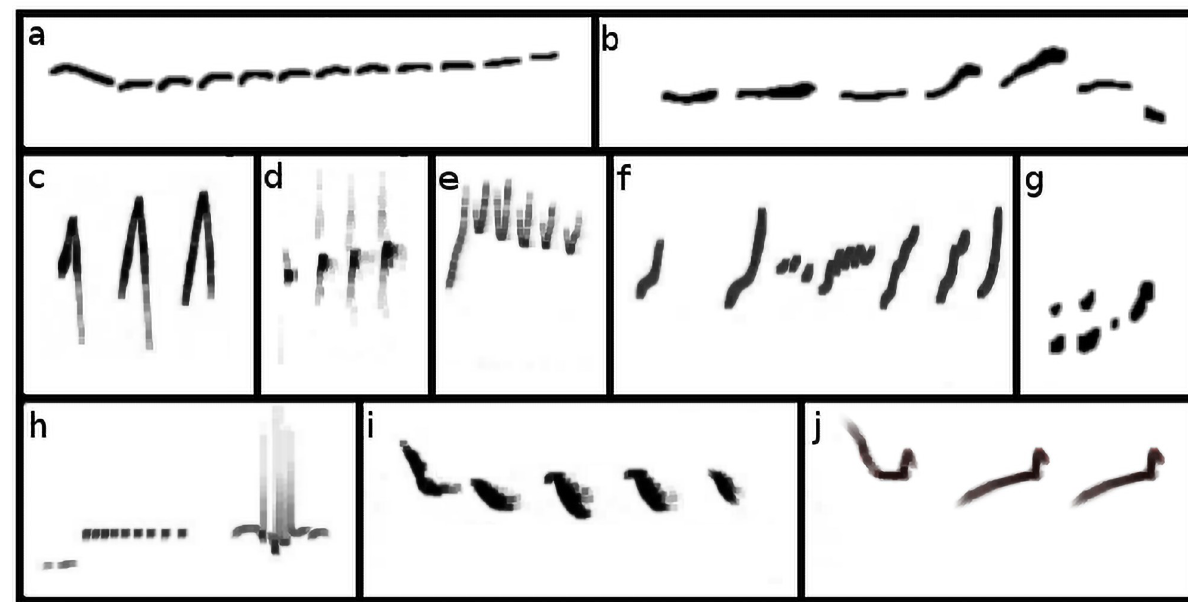
Fig 1. Various spectrographic reproductions of music-like primate calls. Spectrographic representations of ten species’ calls with corresponding max acoustic reappearance diversity index (ARDI) scores formulated as syllables × (P(repetition) + P(transposition)). a : female scream #773 of Tarsius spectrum 2.6 × (0.54+0.56) = 2.8, b: female great call #246 of Hylobates agilis 4.6 × (0.5+0.2) = 3.3. c : location trill #649 of Saimiri sciureus 1.4 × (0.7+0.16) = 1.23, d : tsic #190 of Galagoides demidoff 1.6 × (0.54+0.58) = 1.8, e : twitter #726 of Tarsius syrichta 2.2 × (0.38+0.54) = 2.0, f : quaver interlude #254 of Hylobates lar 4 × (0.6+0.3) = 3.5, g : musical sequence #363 of Macaca fuscata 2.2 × (0.4+0.2) = 1.3, h : male short phrases #861 of Hylobates leucogenys 4.6 × (0.74+0.1) = 3.9, i : modified twitter hook (593) of Saguinus fuscicollis 2.4 × (0.6+0.16) = 1.8, j : alerting call of #88 Cebuella pygmaea 1.8 × (0.6.+0.1) = 1.26. Many of these short calls have high degrees of transposition given their brevity. Such marked inter-element intervals likely suit callers for acoustic adaption to arboreal environments. See S1 File reference list for spectrograph